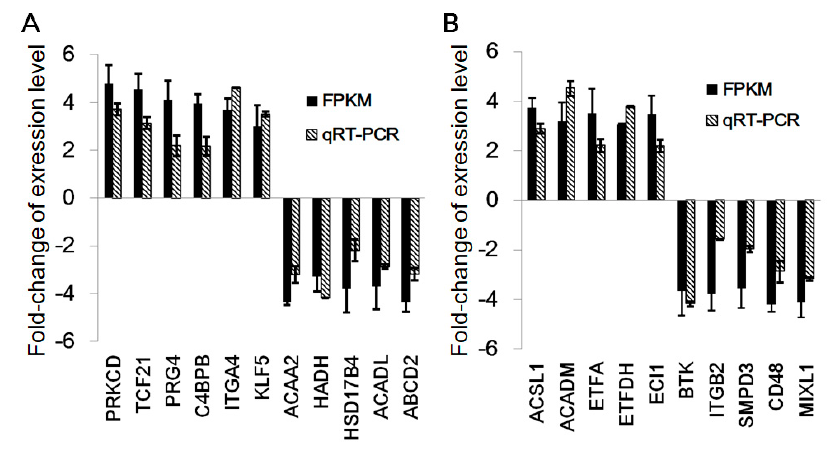
Figure 3. Experimental verification of gene expression level using qRT-PCR. ( A ) The relative expression levels (Min/DL) of 11 DEGs verified in 16-week-old pigs. ( B ) The relative expression levels (DL/Min) of 10 DEGs verified in 16-week-old pigs. Data presented with standard error bars per group ( n = 3).